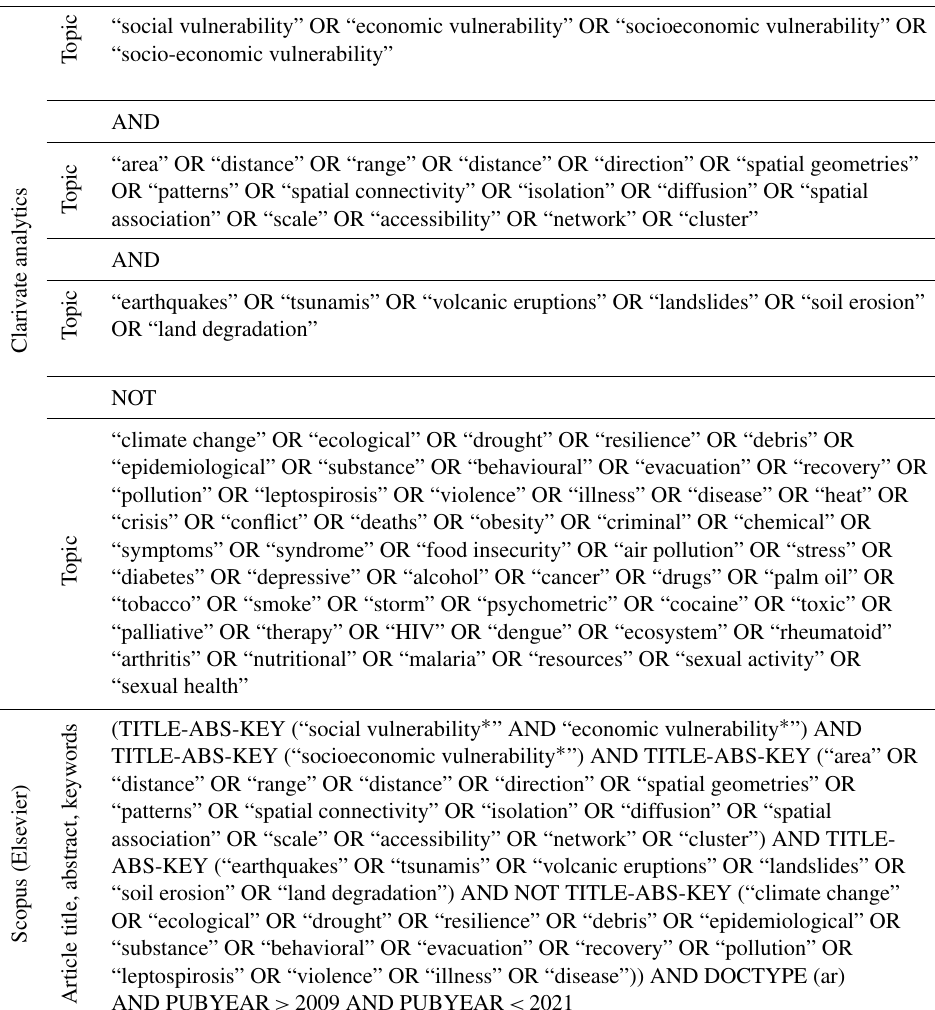
Table 1. Terms included and excluded to identify relevant literature references. D Q Search terms “social vulnerability” OR “economic vulnerability” OR “socioeconomic vulnerability” OR “socio-economic